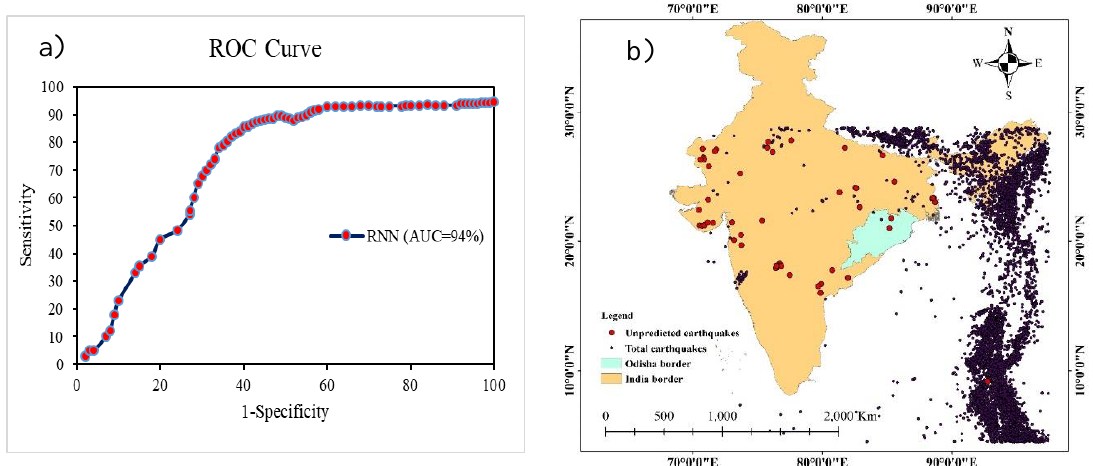
Figure 9. ( a ) Prediction rate curve by RNN; ( b ) unpredicted earthquakes based on RNN.